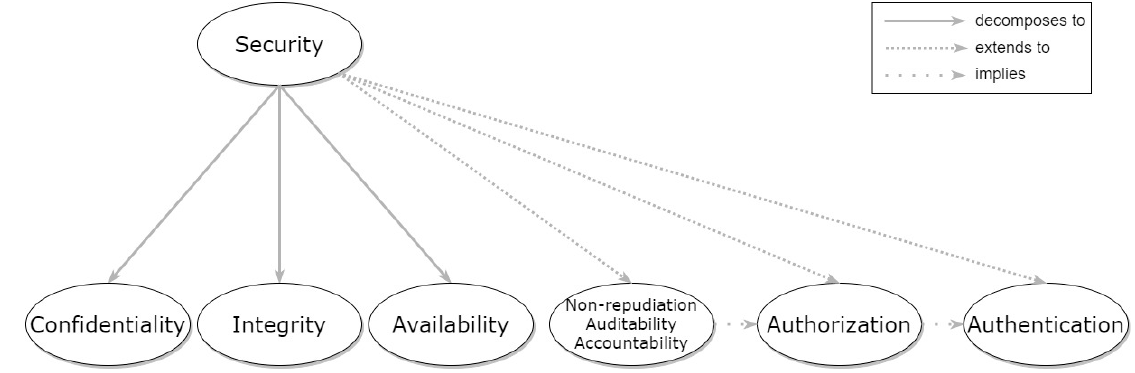
Figure 1. Hierarchical graph of Security and relevant